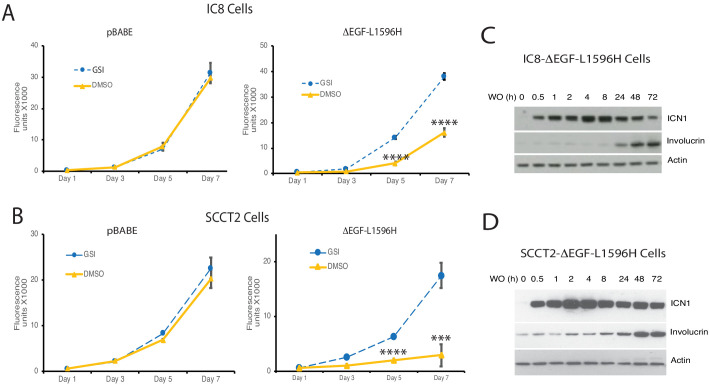
Notch activation induces differentiation and growth arrest of the squamous carcinoma cell lines IC8 and SCCT2.(A, B) Effects of GSI and sham washout on the growth of IC8 and SCCT2 cells transduced with either empty vector (pBABE) or ΔEGF-L1596H. Cell numbers at various times post-GSI washout (DMSO) or sham GSI-washout (GSI) were assessed with Cell Titer-Blue in biological replicates prepared in quadruplicate. Timepoints with significantly different cell growth between Notch-on cells (DMSO, empty vector) and Notch-off cells (GSI) are denoted with *** (p<0.005) or **** (p<0.0005) (two-tailed student t test). (C, D) Western blot showing the kinetics of ICN1 generation and increases in involucrin (IVL) following GSI washout (WO) in IC8 and SCCT2 cells transduced with ΔEGF-L1596H.